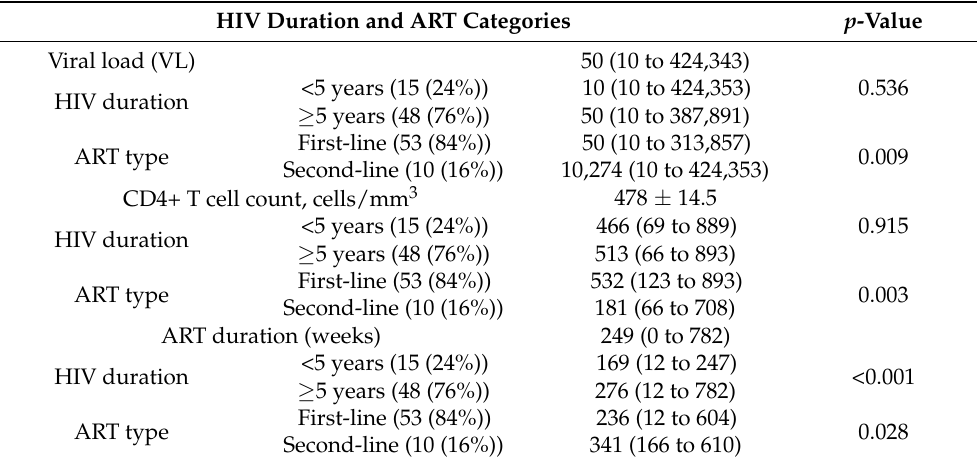
Table 2. VL, CD4+ T count, and ART duration categorised per HIV duration and ART regimen.